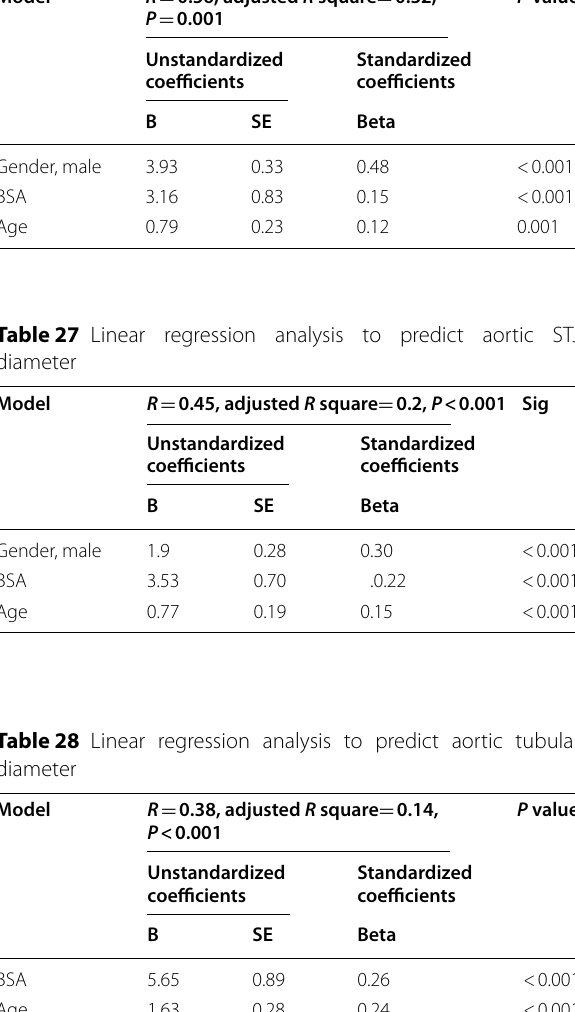
0.38, adjusted R square = P < 0.001 Unstandardized coefficients